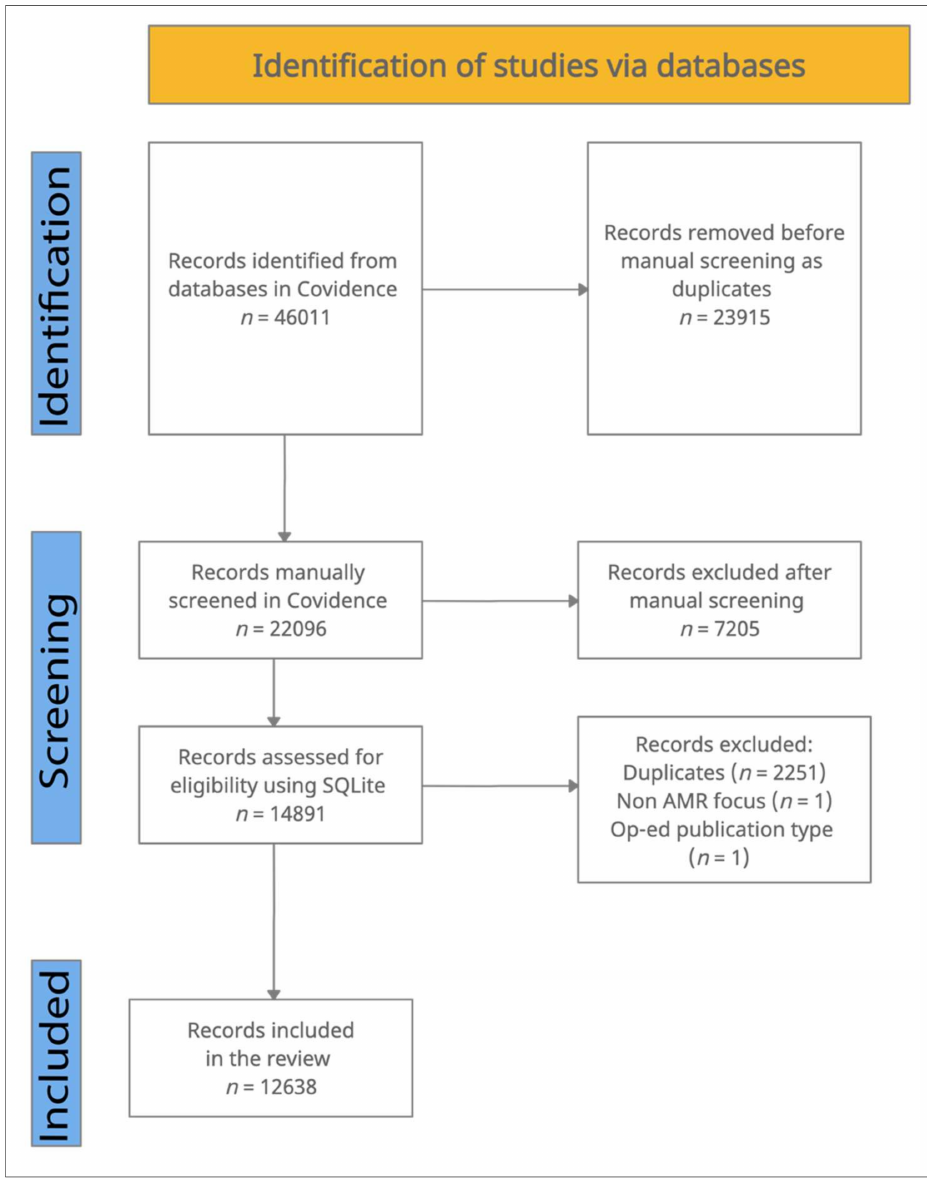
Figure 1. PRISMA diagram outlining the article record selection process. Table 1. Antimicrobial resistance research and interventions—rapid review inclusion and exclusion criteria for manual and secondary screening